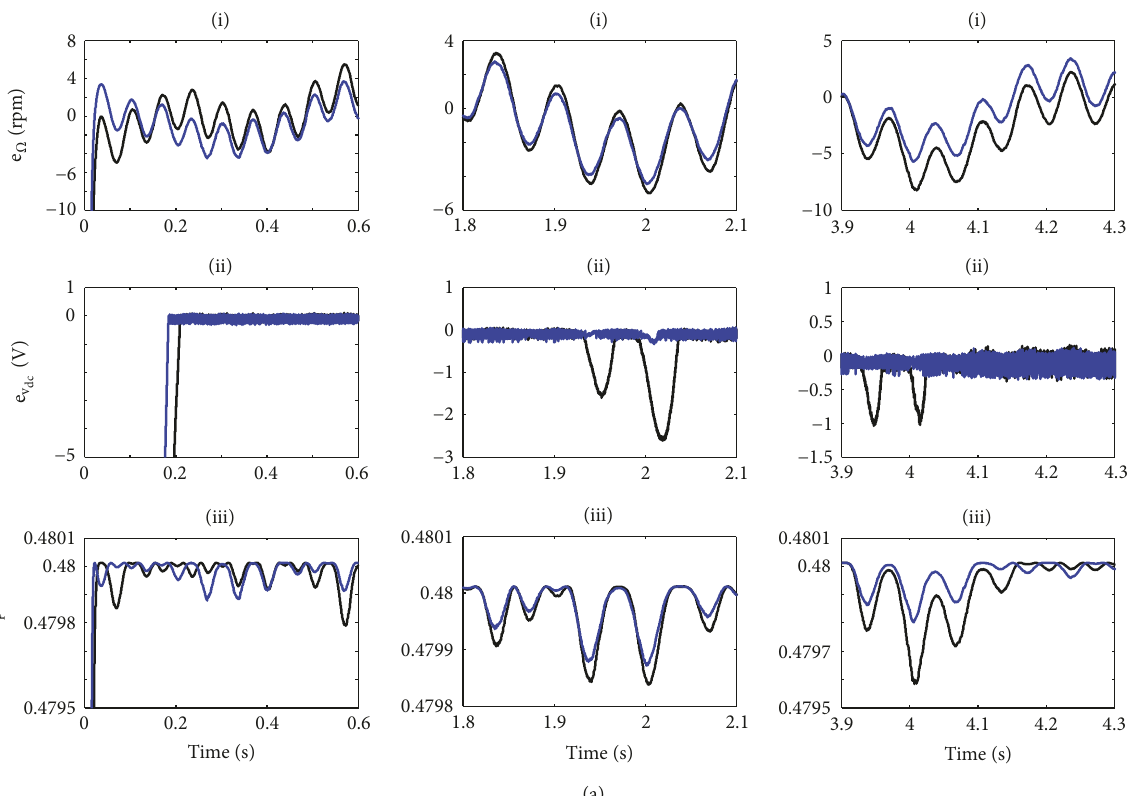
Figure 7: Control system response to wind speed fluctuations with nominal values of parameters. Zoom on (blue line: RBF-NSMC, black line: SMC): (i) Generator speed error, (ii) dc-link voltage error, and (iii) power coefficient.